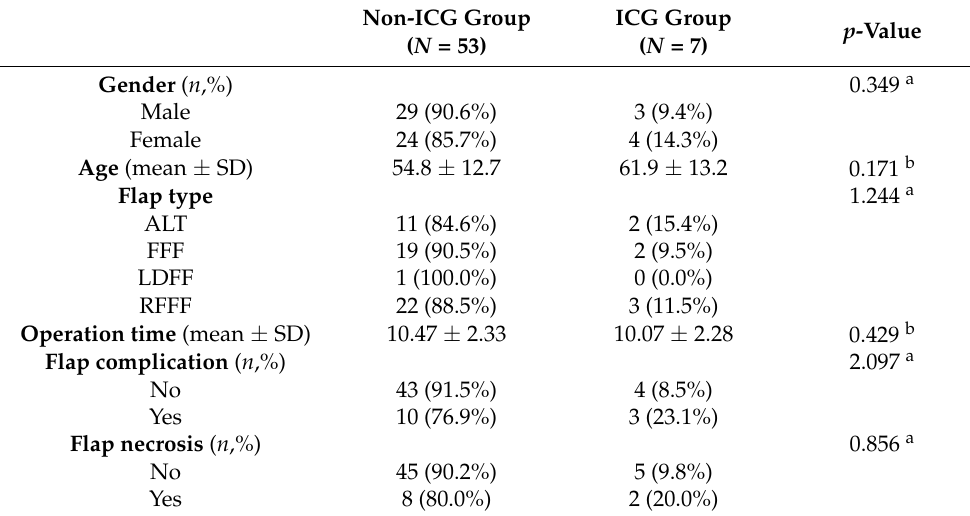
Table 2. Baseline characteristics and operational indexes of the patients in both groups.